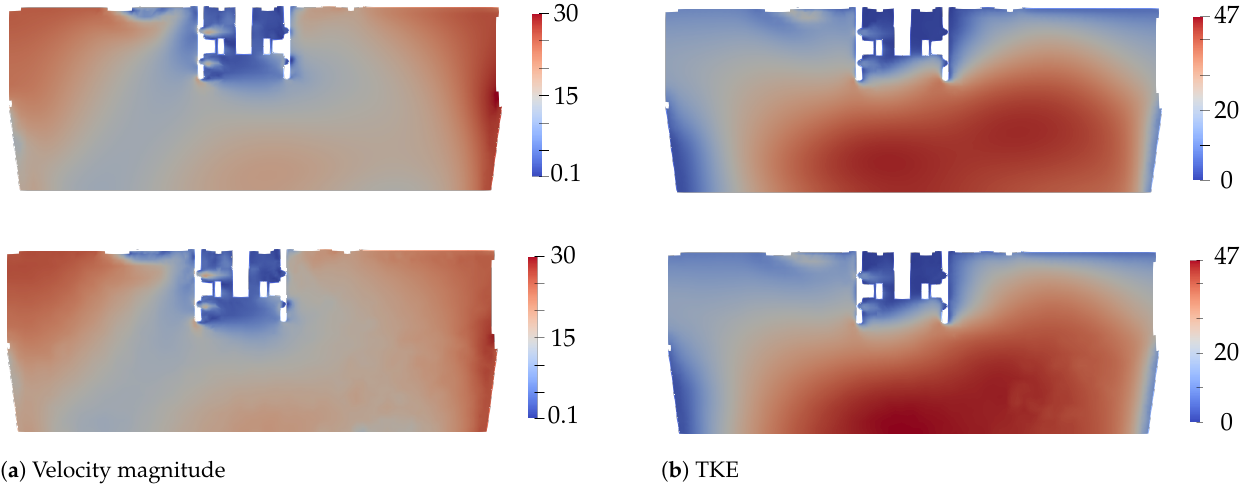
Figure 11. Velocity magnitude and TKE in a cut plane through the spark plug from the original multicycle dataset and the VAE generated